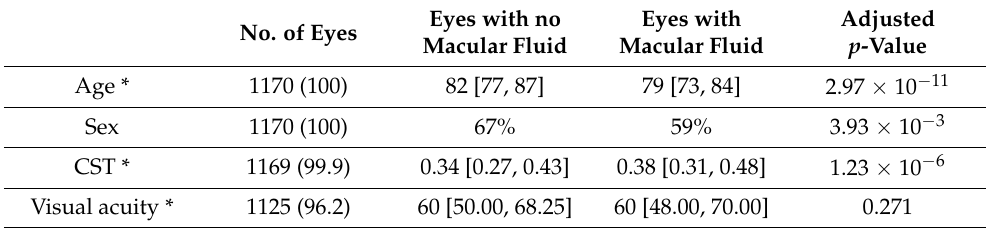
Table 2. Association of features of interest with therapy response for the standard protocol subcohort. Eyes with No. of Eyes